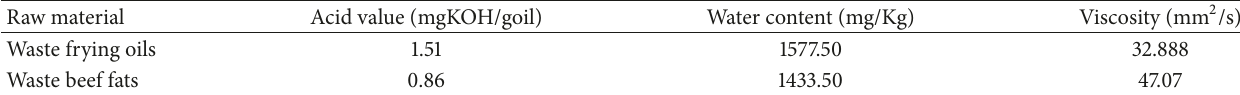
Table 1: Determination of acid value, water content, and viscosity of raw WFO and WBF.